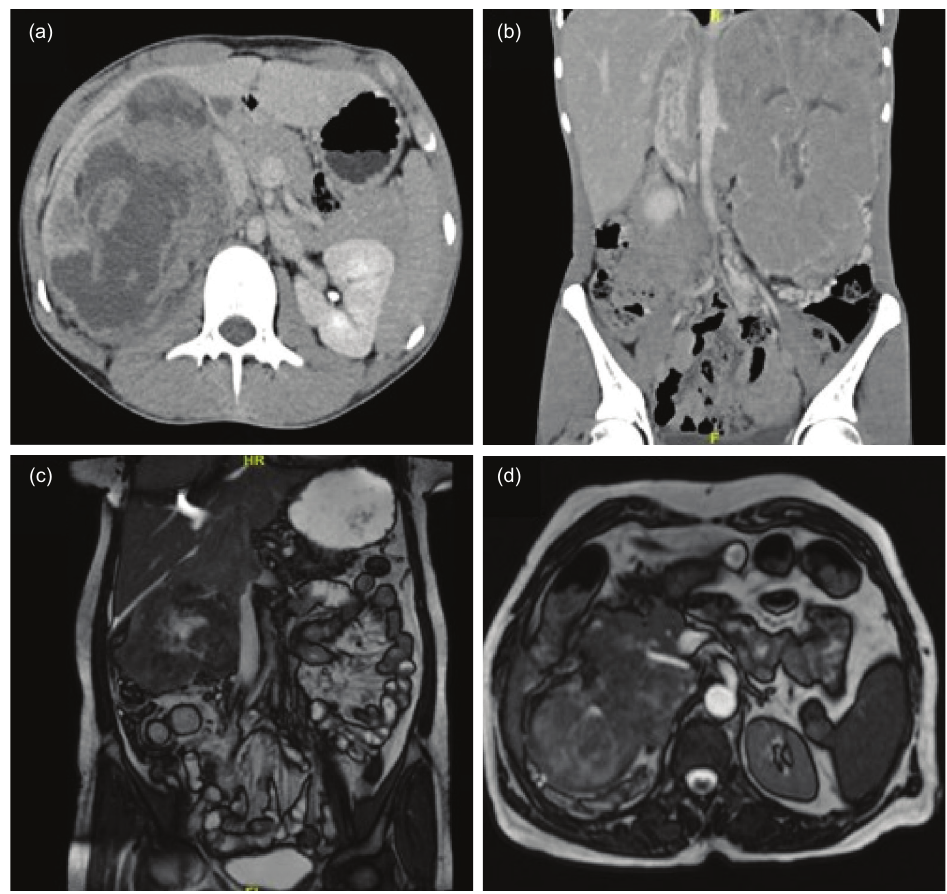
Figure 1: (a) CECT abdomen and pelvis transverse section (Case 1) showing right renal mass, compressing medially the right renal vein, ureter, and IVC with sectoral contact of about 180° with no apparent tumor thrombosis. (b) CECT thorax and coronal abdomen section (Case 2) revealed that left renal mass lesion with enhancing tumor thrombus extending up to the supradiaphragmatic IVC. (c) Plain MRI abdomen coronal section (Case 3) showing well-defined lobulated mass lesion with IVC thrombosis extending into the suprarenal IVC, below the diaphragm. (d) MR urography transverse section (Case 4) show- ing a well-defined mass of size 8 × 6 cm involving the renal pelvis, compressing IVC anteriorly. IVC, inferior vena cava; CECT, contrast-enhanced computed